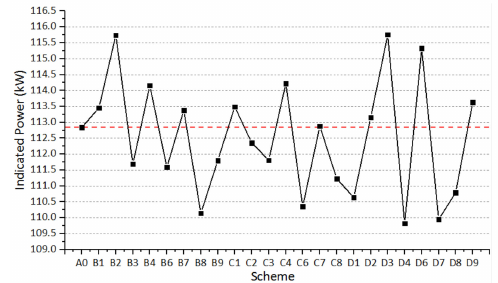
Figure 46. Indicated power of each optimized design scheme.